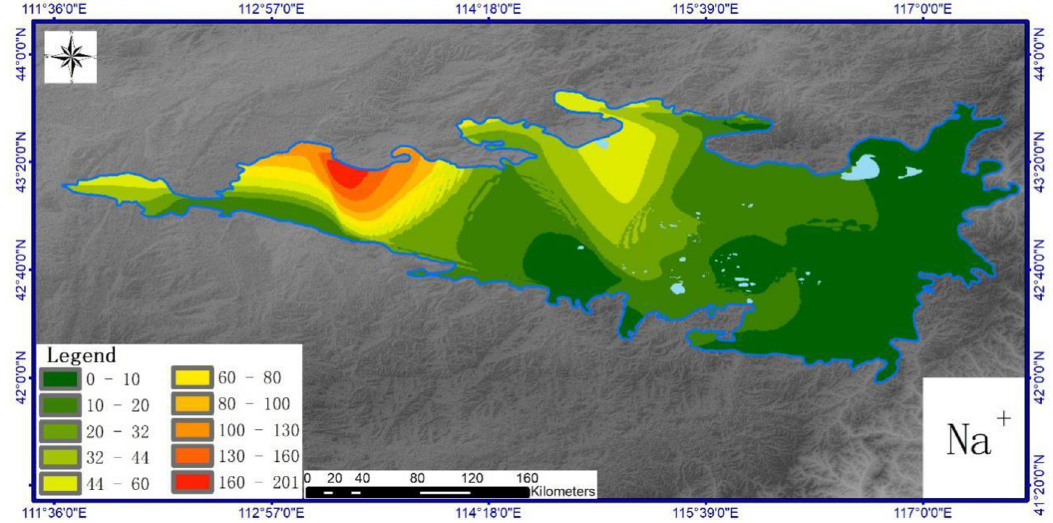
Fig 7. Spatial distribution of soil Na + in Hunshandake sandy land (Cartographic software:Arcgis10.5).